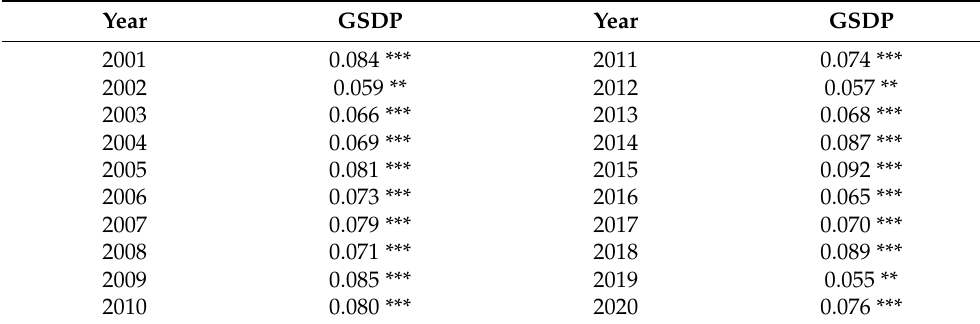
Table 3. Results of Global Moran’s I of GSDP from 2001 to